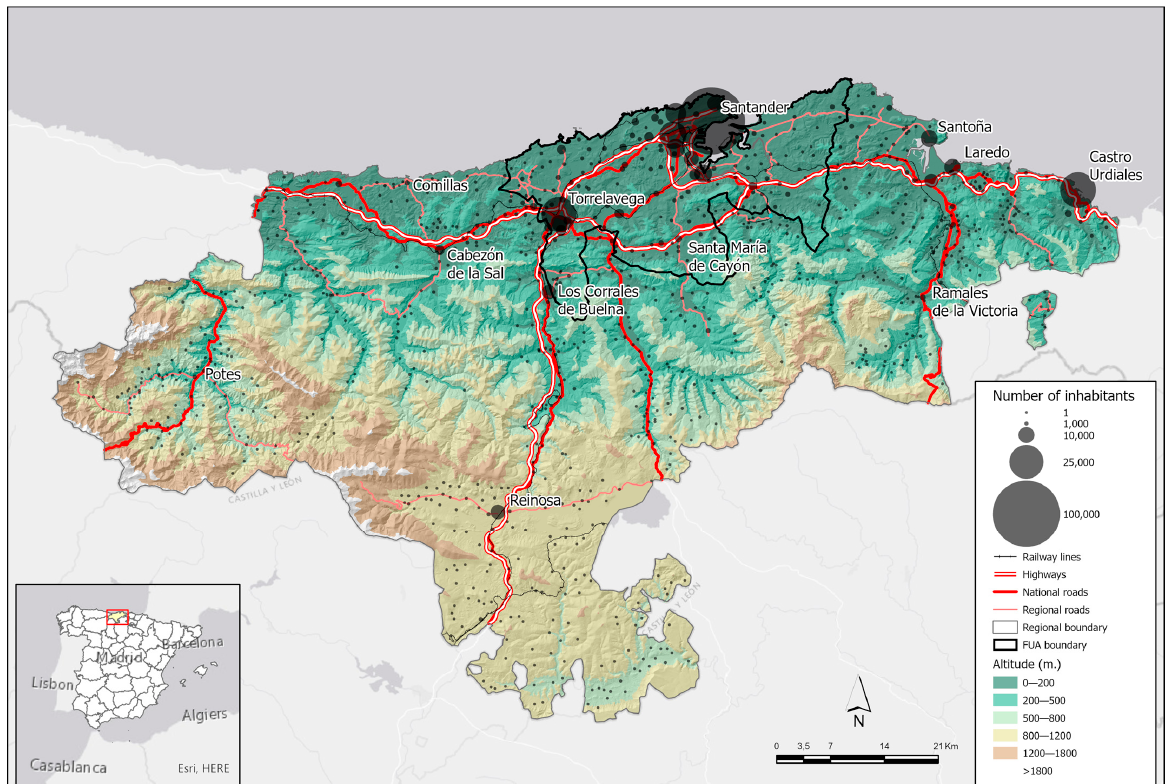
Figure 1. The study area of Cantabria in the national context: settlements, functional urban area (FUA) and main com- munication infrastructures. Source: Own work based on ESRI (administrative base map), National Geographic Institute (National Cartographic Base 200) and Government of Cantabria (digital elevation